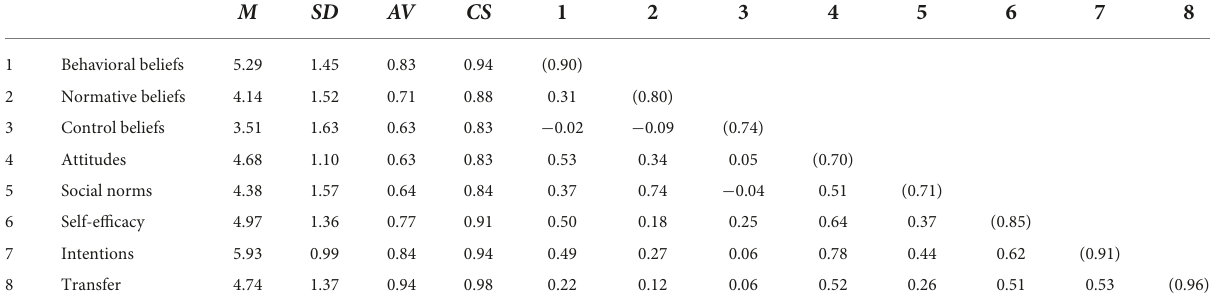
TABLE 2 Psychometric properties and correlation